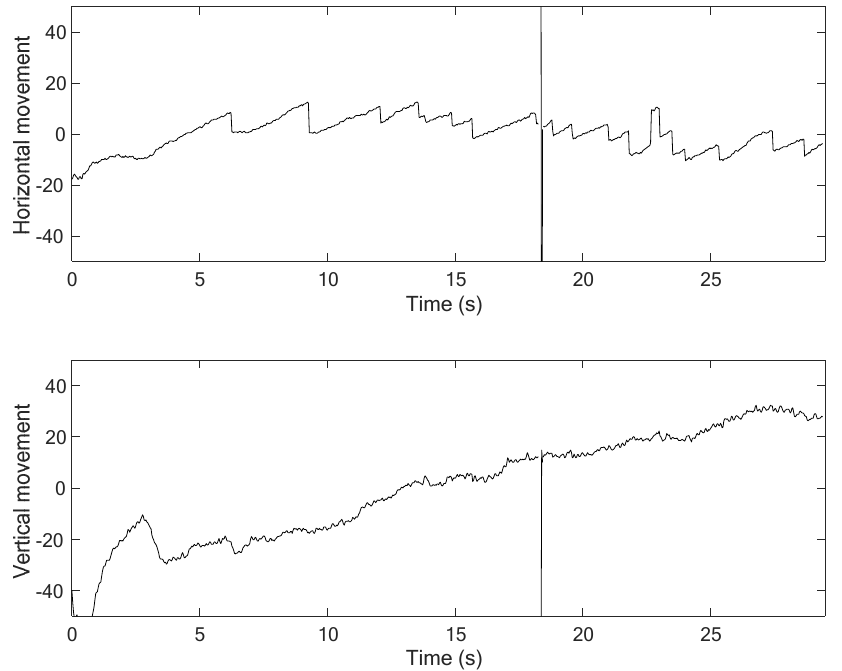
Figure 8. Sample of the nystagmus waveform generated by the proposed method.